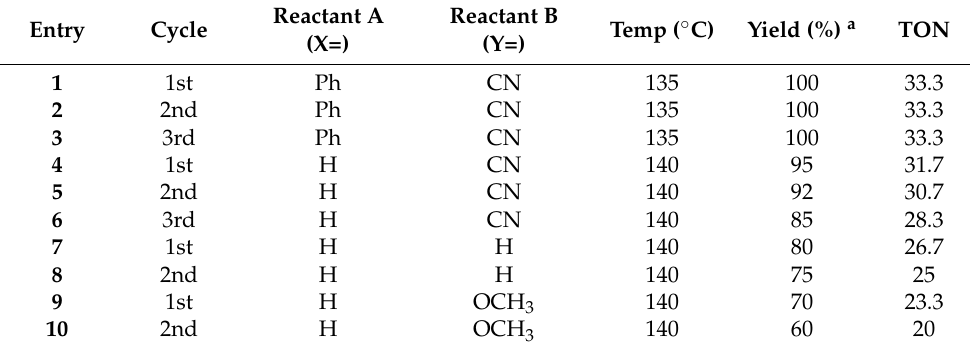
Table 8. Recycling results of 2a -catalyzed Suzuki-Miyaura reaction of two phenyl boronic